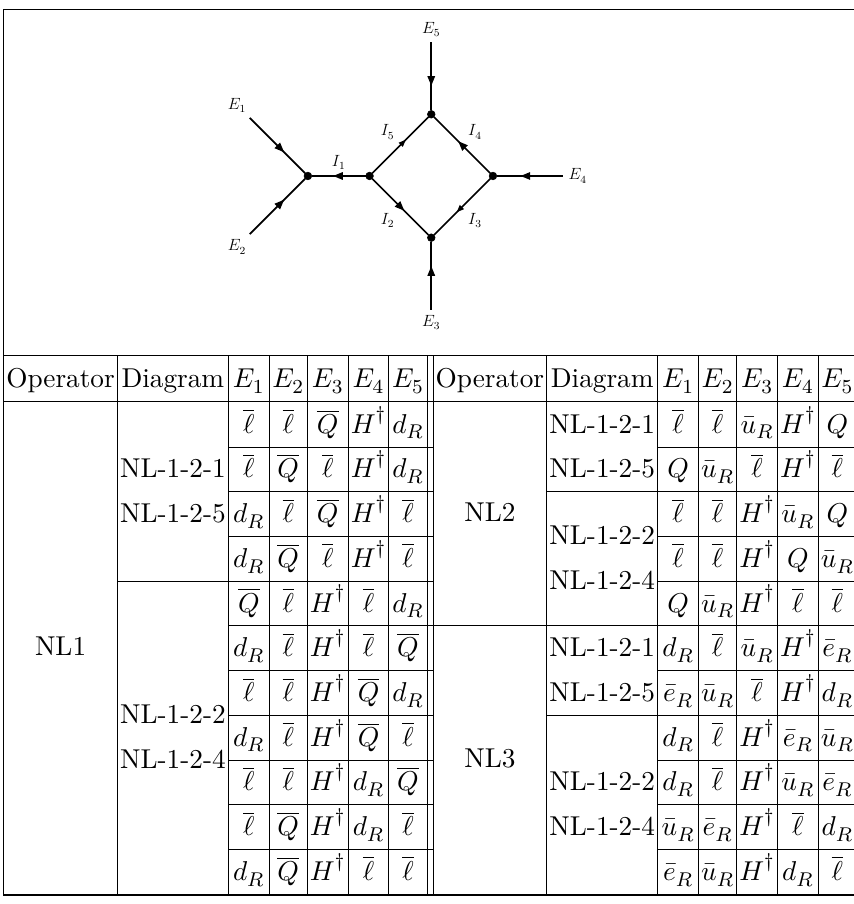
and I respectively ( continues... i i